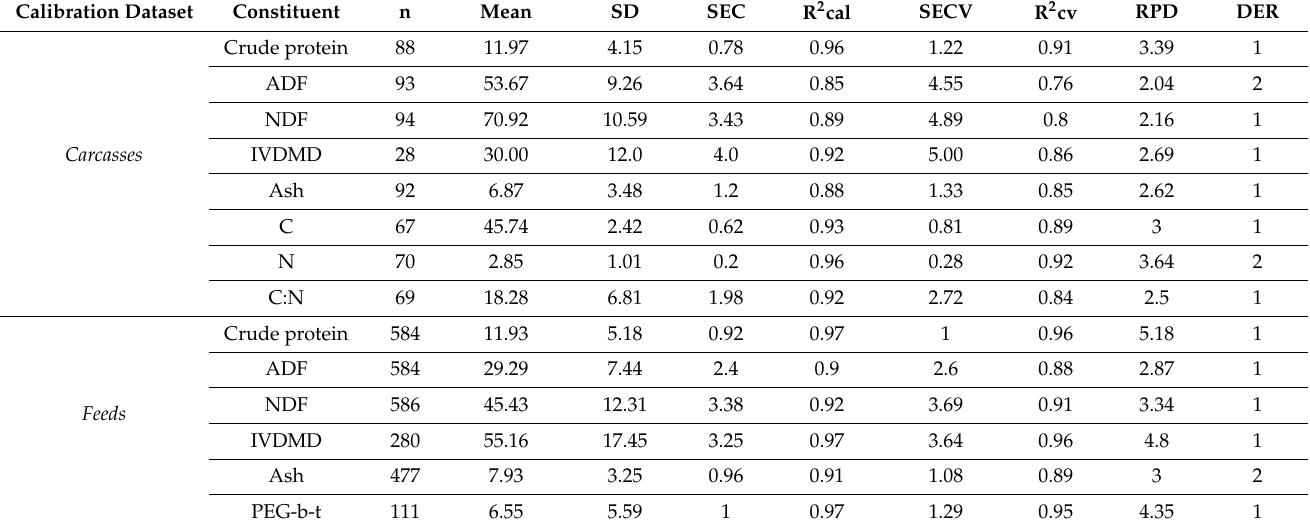
Table 4. Near-infrared spectrometry calibration performance, for the prediction of the chemical composition of gazelle rumen contents, including the number of samples used for each calibration (n), the mean and the standard deviation (SD) of measurements, standard errors of calibration (SEC) and cross-validation (SECV), calibration (R 2 cal) and cross-validation (R 2 cv) coefficients, the ratio of performance to deviation (RPD), and derivatives used in mathematical treatment (DER, 1st or 2nd). In bold, the calibrations selected for the analysis of rumen contents from 105 gazelles in the survey. Calibration Dataset